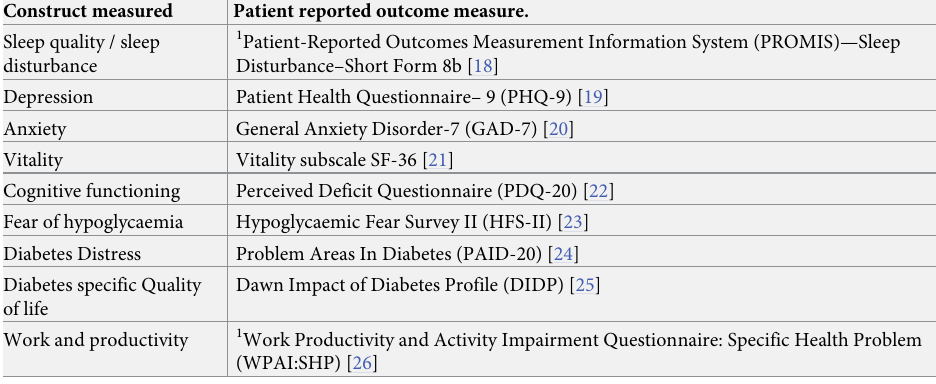
Table 1. Construct measured Patient reported outcome